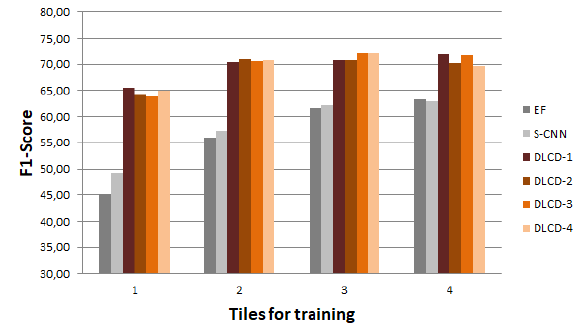
Figure 5. F1-score × number of tiles for training.